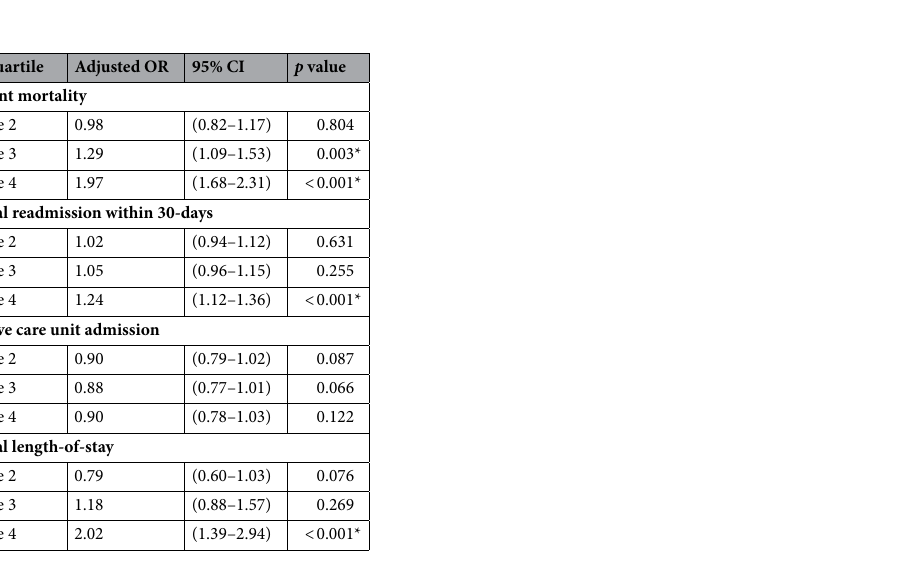
Table 3. Clinical outcomes associated with urea-to-creatinine ratio level. UCR Urea-to-creatinine ratio; OR Odds ratio; 95% CI 95% Confidence interval; IR incidence ratio. Odds/incidence ratios were adjusted for age, sex, CCI score, eGFR and acute kidney injury status on admission by multivariate logistic regression analysis. * p value < 0.05 in multivariate analysis was considered statistically significant.